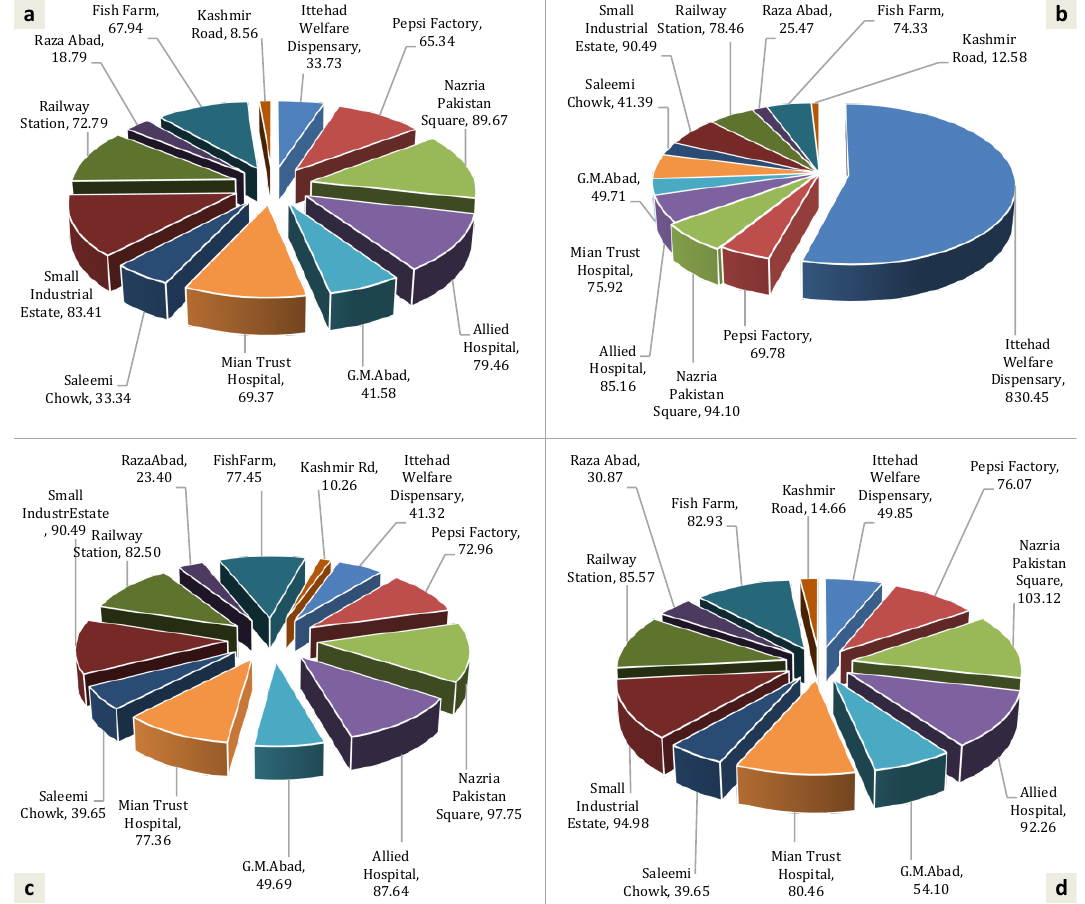
Figure 3. Concentration of carbonaceous species—elemental carbon (EC) in PM 2.5 in summer ( a ); PM 2.5 in winter ( b ); PM 10 in summer ( c ); PM 10 in winter ( d ). All units are expressed in µ g / m 3